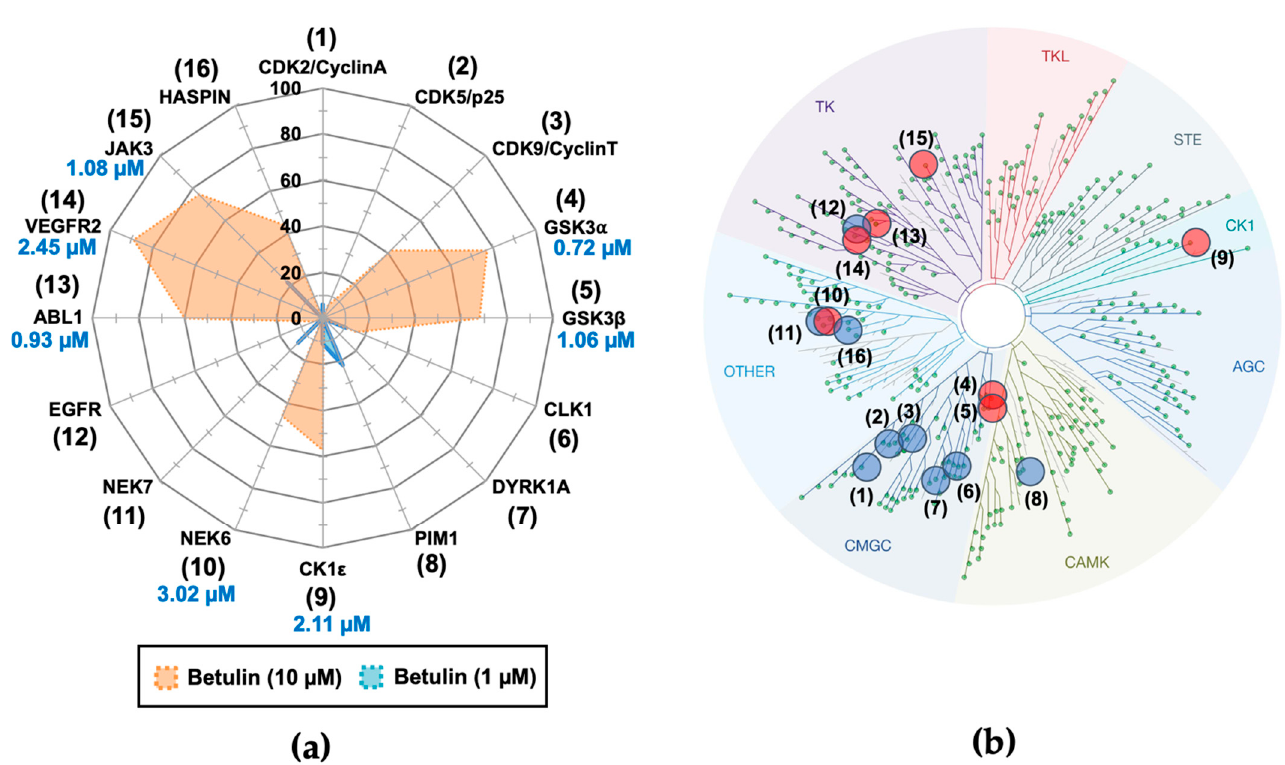
Figure 2. Selectivity of betulin against a panel of 16 disease-related protein kinases. ( a ) The value reported on the Kiviat chart is mean (n = 2) expressed in % of inhibition, compared with a DMSO control. The IC 50 values in µM are listed below the name of each tested kinase. As betulin was not abundant in Acacia bark, we used a commercially-available betulin, provided by Sigma (reference #B9757). All protein kinases used here are human except DYRK1A ( Rattus norvegicus ) and CLK1 ( Mus musculus ). ( b ) The targets used here are selected from the human kinome as represented in the panel by blue dots on the circular tree. Red dots indicate that the kinase is inhibited by betulin. This image was generated using the TREEspot™ Software Tool (Eurofins DiscoverX Corporation, Fremont, CA, USA) and reprinted with permission from KINOMEscan ® , a division of Eurofins DiscoverX Corporation (© DiscoverX Corporation 2010). The codes reported on this figure indicate the subclasses of protein kinases: CMGC for CDKs, MAP kinases, GSK, and CDK-like kinases; AGC for protein Kinase A, C, and G families (PKA, PKC, PKG); CAMK for Ca 2+ /calmodulin-dependent protein kinases; CK1, Cell/Casein Kinase 1; STE, STE Kinases (Homologs of yeast STErile kinases); TKL, Tyrosine Kinases-Like; and TK, Tyrosine Kinases.